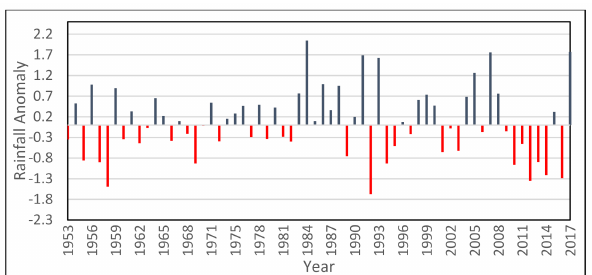
Figure 5. Rainfall anomalies at Dhaka (1953–2017) relative to the 1989–2017 average.